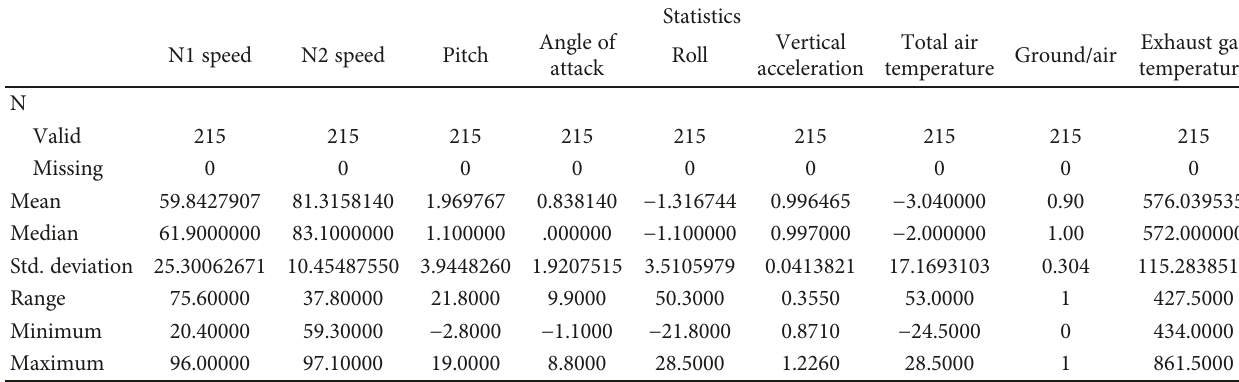
Table 3: Test data range used in the prediction of EGT.